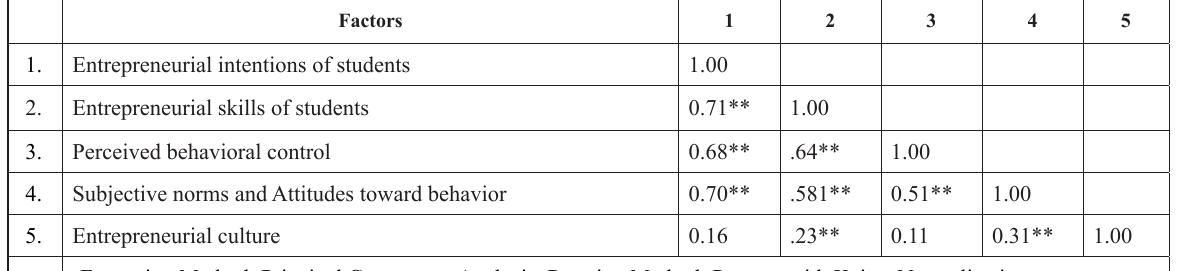
Table 7. Pearson’s intercorrelation coefficients (r) of the entrepreneurial intentions factor of students